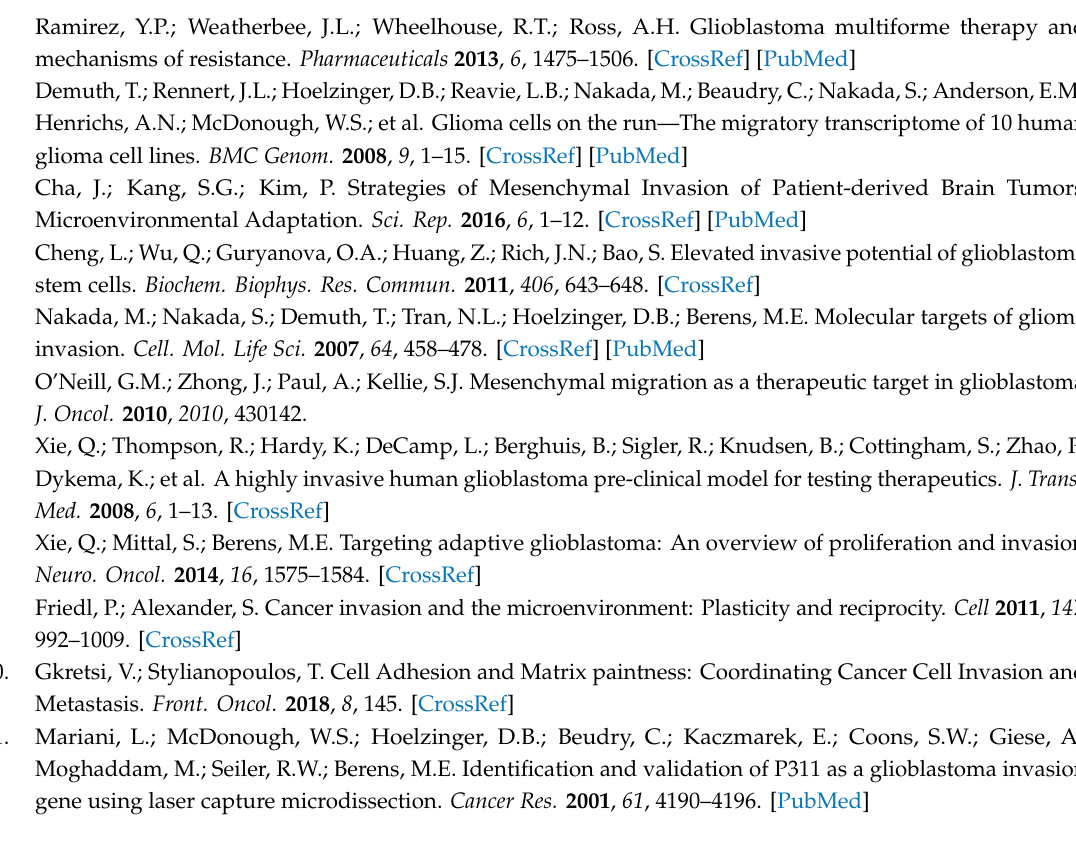
Figure S1: U373 cell line-derived spheroids are more dispersive than other GBM cell lines tested, Figure S2: Transcriptome of core and dispersive cells have major di ff erences, Figure S3: SERPINE1 is upregulated in dispersive cells, Figure S4: Endogenous expression levels of selected EMT genes among cell lines, Figure S5: E ff ect of SERPINE1 knock-down with two di ff erent shRNAs on dispersal, Figure S6: SERPINE1 knock-down does not dramatically a ff ect the expression levels of EMT genes, Figure S7: SERPINE1 inhibitor tiplaxtinin reduces dispersal of additional primary GBM cell lines, Figure S8: Tiplaxtinin does not a ff ect the cell viability of U373 and GBM8 cells, Figure S9: CTGF or CYR61 knock-down reduces the dispersal of U373 spheroids, Figure S10: Knock-down of CDC45 or MCM3 reduces U373 cell viability and spheroid dispersal, Figure S11: Vitronectin increases dispersal without changing SERPINE1 expression, Figure S12: TGF β is an upstream regulator of U373 dispersal, Figure S13: Original Western blot images and densitometry analysis for Western blot experiments, Table S1: Q-RT PCR primer sequences, Table S2: shRNA sequences, Videos S1–S4: Live-cell imaging experiment videos for control and SERPINE1 knock-down U373 cells with no coating or on vitronectin coating, Videos S5 and S6: